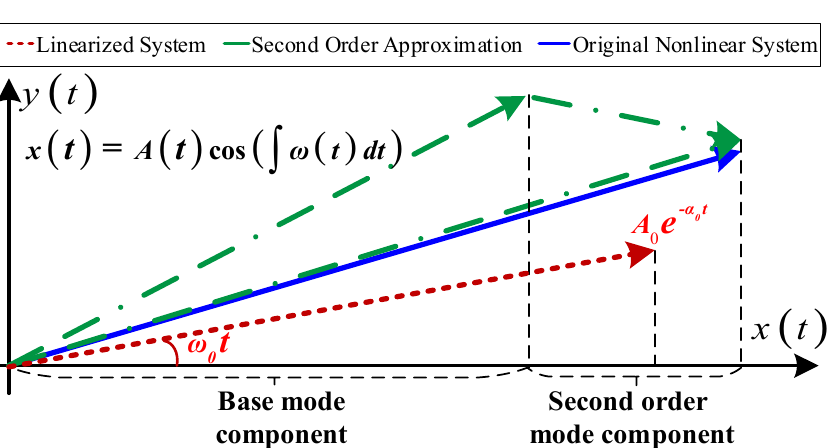
Figure 18. Fourier spectra of simulated results.